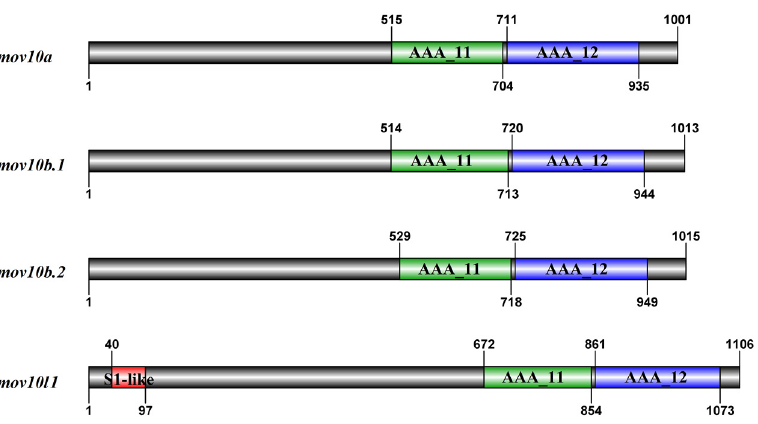
Figure 6. The schematic diagrams of domain organization in zebrafish Mov10s and Mov10l1. The bold black lines mean the amino acid sequence of the proteins. The higher squares represent the predicted domains of Mov10s and Mov10l1.